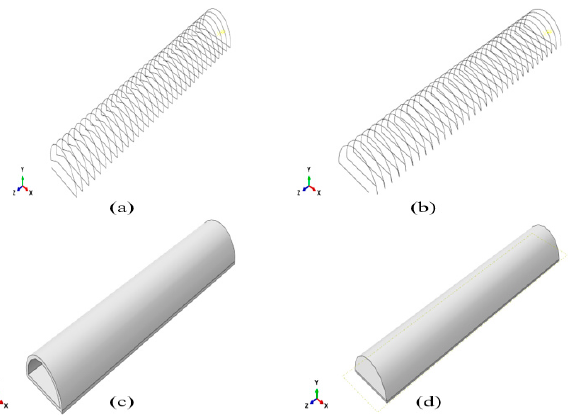
Figure 6. FE model of each of the actuator’s parts. ( a ) Counterclockwise cable. ( b ) Clockwise cables. ( c ) Outer layer. ( d ) Tube.